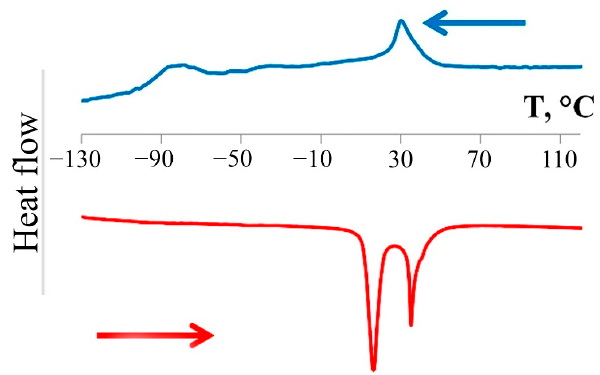
Figure 8. DSC curves for heat-treated specimen.